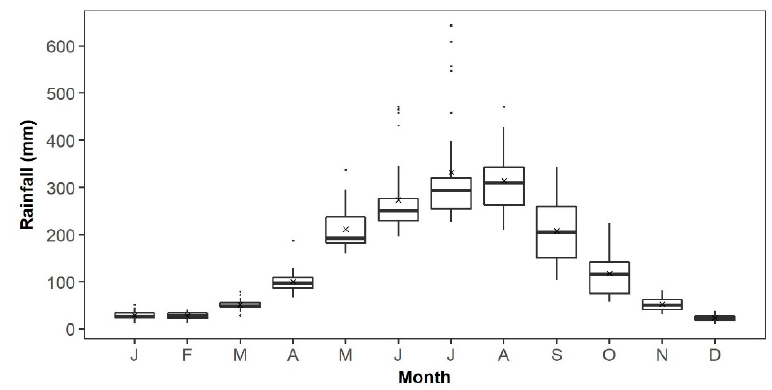
Figure 2. Monthly rainfall distribution over Red–Thai Binh River Basin (March 2000–December 2016). Cross symbol indicates average monthly rainfall.